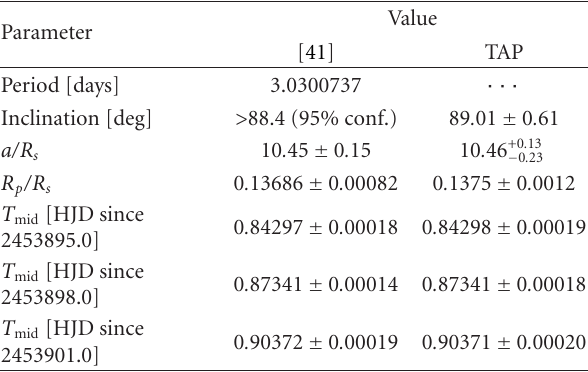
Figure 3: Parameter extraction from Bayesian posterior probability distribution. The solid black histogram displays a Bayesian posterior probability density distribution for the parameter a/R s of the combined analysis of three light curves of WASP-10b (Section 3.1). The solid vertical line marks the median (50.0 percentile), while the dashed vertical lines represent the ± 1 σ inferred statistics described in Section 2. The additional histograms represent the posterior distributions for independent analyses of each curve (V: dashed green, R: dash-dotted red, I: dotted gray). Table 2: Analysis of 3 [41] TrES-1b light curves.